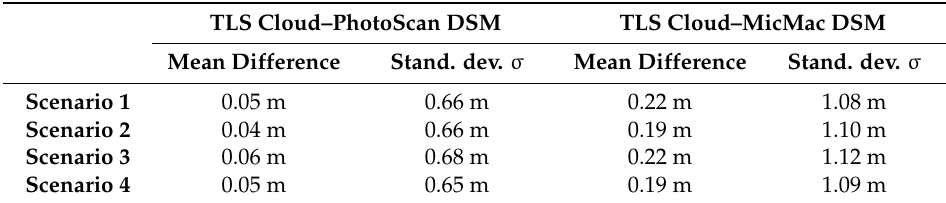
Figure 8. ( a – h ) Comparison between the TLS point cloud and the DSMs computed by PhotoScan ® ( left ) and by MicMac ( right ) for the different scenarios. Table 3. Comparison between the TLS point cloud and both photogrammetric DSMs.